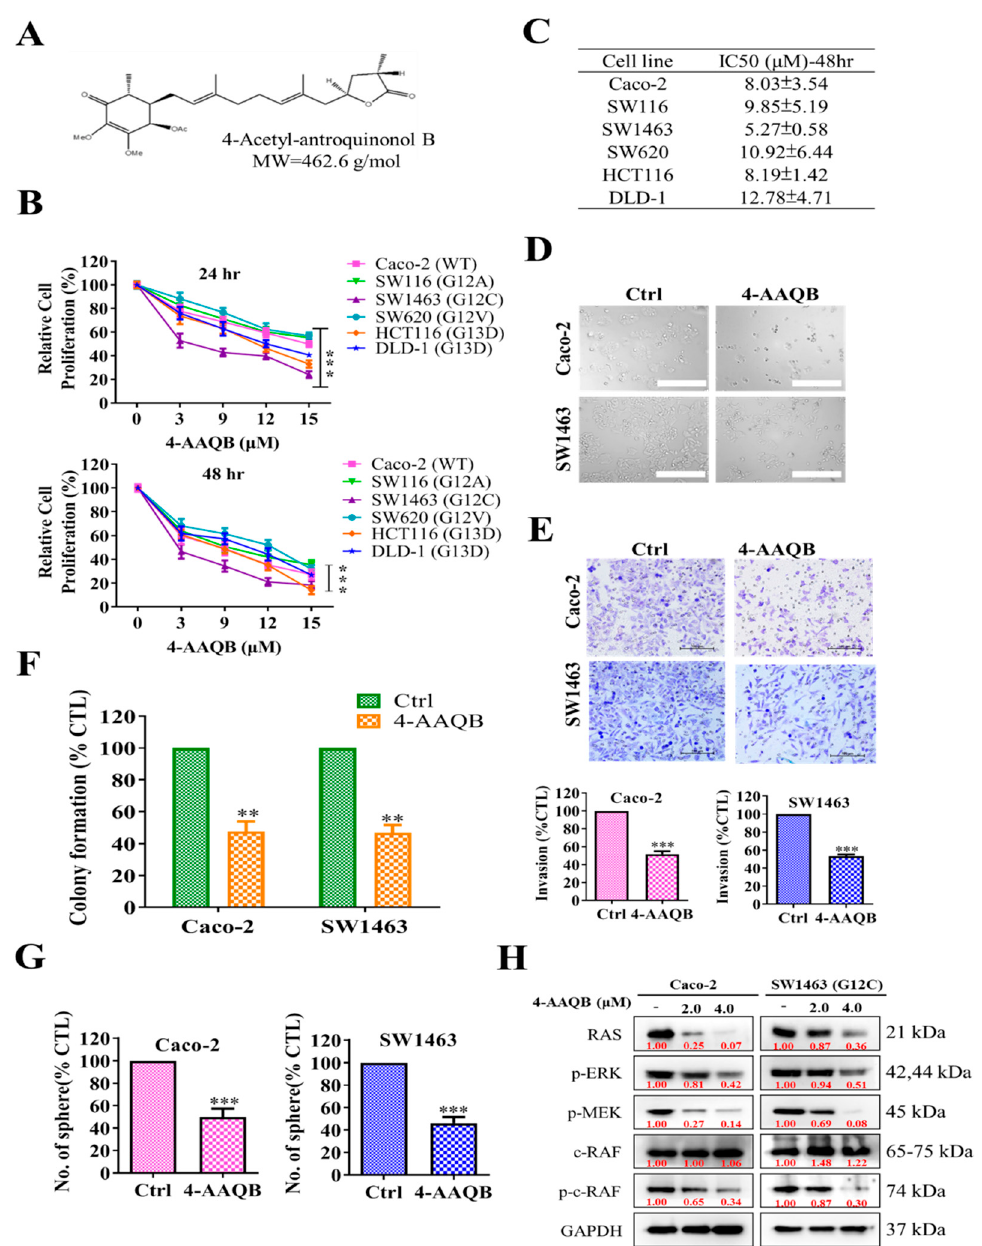
Figure 3. The effect of 4-acetyl-antroquinonol B (4-AAQB) on cell growth and oncogenic characteristics of KRAS wild and KRAS mutant CRC cell lines. ( A ) The chemical structure of 4-AAQB (C26H38O7), ( B ) cell proliferation analysis based on SRB assay of CRC KRAS wild and mutant cell lines. The graphic represents the relative proliferation of the cells following 24 and 48 h of treatment related to control. ( C ) IC 50 -dosage of 4-AAQB on CRC cells. ( D ) Effect of 4-AAQB on the morphologies of the KRAS-mutant (SW1463) and KRAS wild-type (Caco-2) CRC cells as observed through phase-contrast microscopy image at 200 × magnification. ( E – G ) Reduced migration, colony-forming and tumorsphere formation ability of SW1463 and Caco-2 cells after 4-AAQB treatment. ( H ) Representative image of Western blot analysis was performed to determine the level of key members of the Raf/MEK/ERK and Ras pathway in response to 4-AAQB treatment on the cetuximab resistant CRC KRAS mutant cells. ** p < 0.01; *** p < 0.001. Scale bar 100 µM.